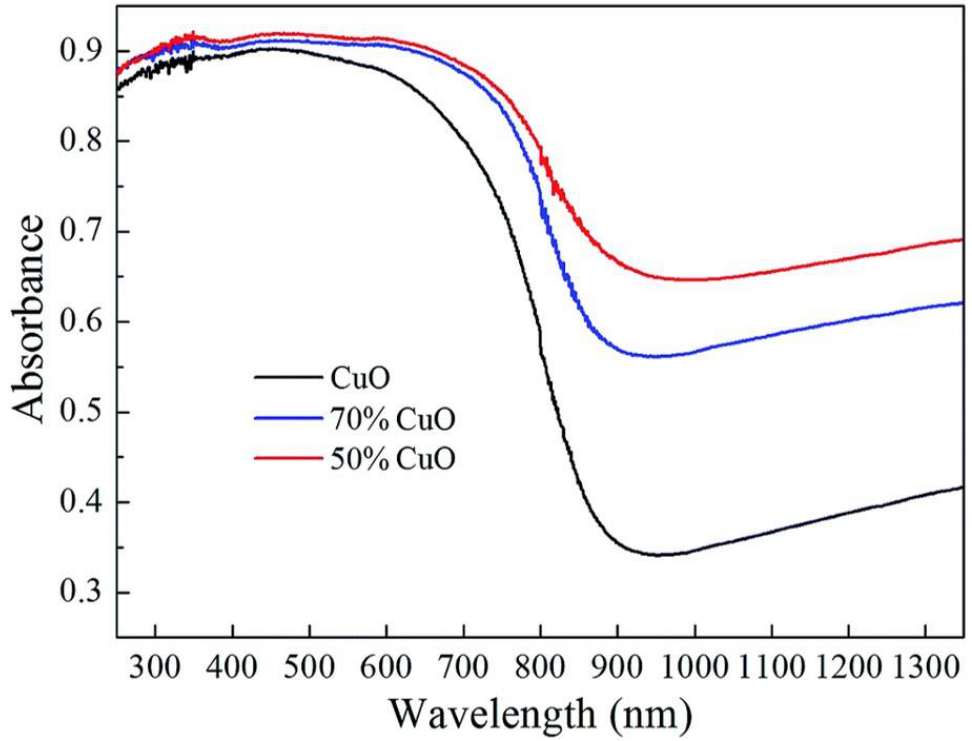
Figure 7. Diffuse reflection absorbance of CuO nanofluid [48]; 2017, RSC. Figure 7. Di ff use reflection absorbance of CuO nanofluid [48]; 2017,